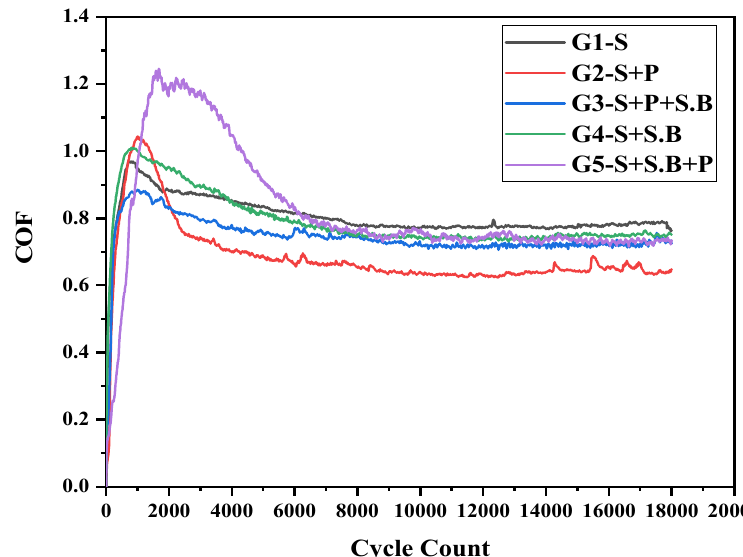
Figure 10. Coefficient of friction as a function of the cycle count for Y-TZP specimens in different groups.